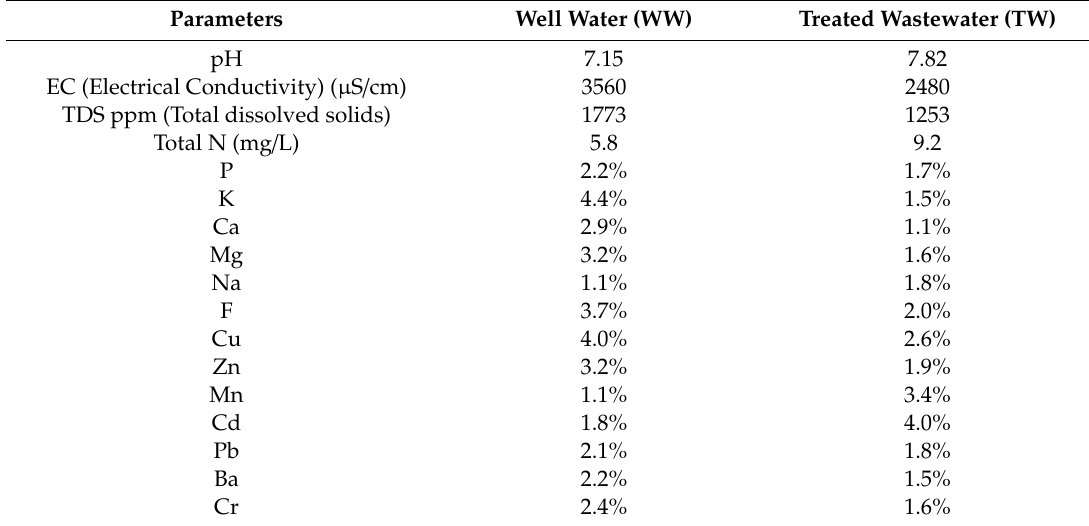
Table 1. Chemical and physical properties of the water types used for irrigation.